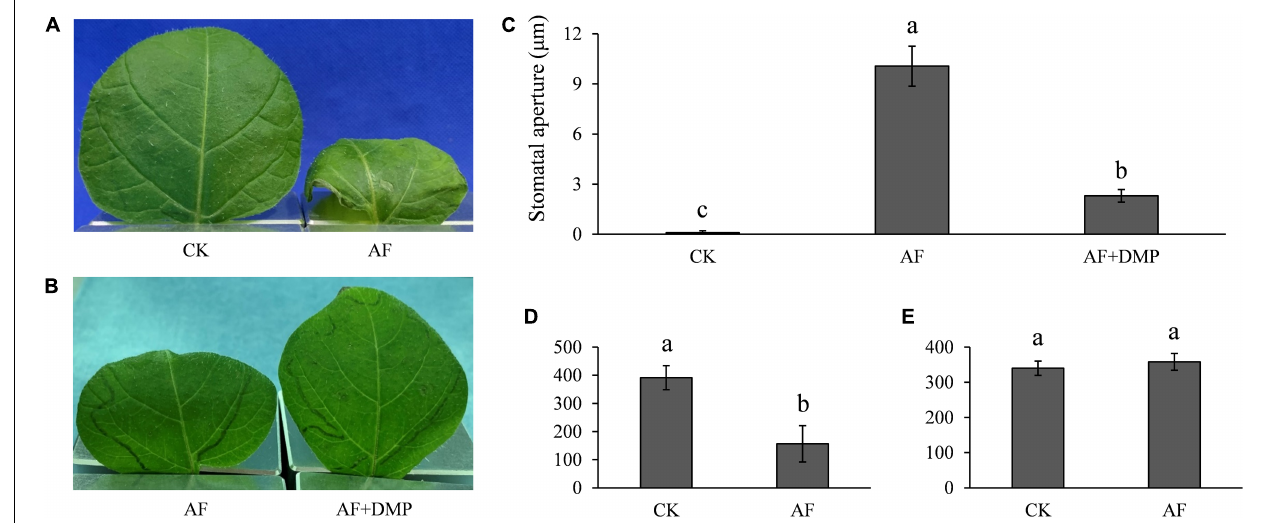
FIGURE 9 | Apoplastic fluids (AFs) induced stomatal opening and TAG breakdown: (A) accelerated water evaporation in AF infiltrated potato leaves; (B) accelerated water evaporation by AF infiltration was reversed by DMP; (C) stomata was opened by AF treatment and the aperture size was compromised by DMP; (D) reduced TAGs in potato guard cells by AF treatment; and (E) AF had no effect on starch content at 15 h post inoculation in potato guard cells. Photos within a panel are from a representative of a single replicate while photos among panels are pooled from multiple